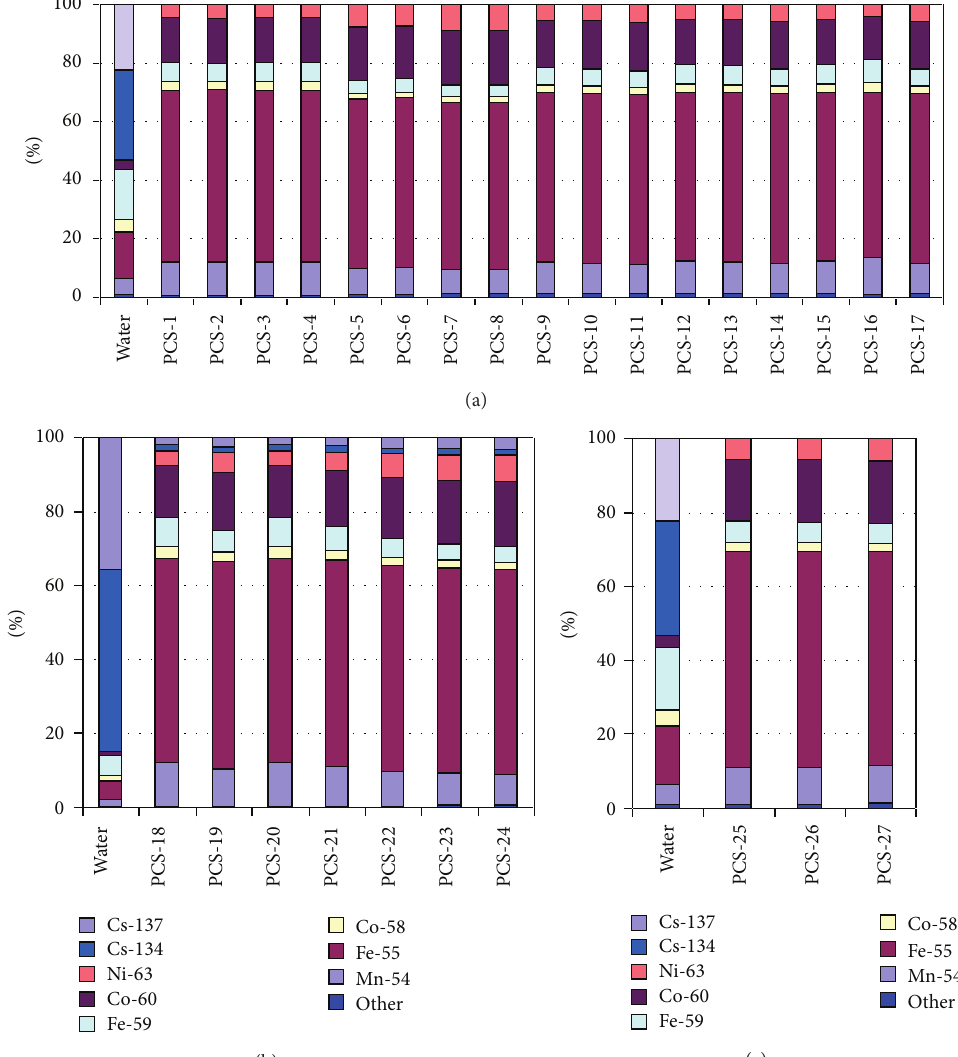
Figure 4: Nuclide composition of the deposits in the PCS: (a) nonpurified water subsystem, (b) purified water subsystem, and (c) additional water cooling subsystem (other <